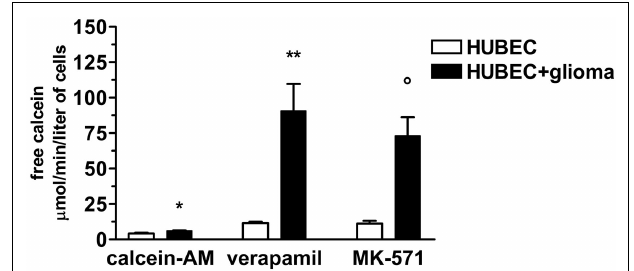
FIGURE 5 | Calcein uptake by brain endothelial cultures in the presence or absence of P-gp and MRP-1 inhibitors (verapamil and MK-571, respectively). The results are expressed as mean ± SEM of duplicate batches of three independent cultures in the presence or absence of glioma cells from three different tumors listed in Table 1 ( n = 3). Calcein-AM, brain endothelial cultures exposed to calcein-AM;Verapamil, brain endothelial cultures preincubated with verapamil; MK-571, brain endothelial cultures preincubated with MK-571; HUBEC, human brain endothelial cells; HUBEC + glioma, human brain endothelial cells in the presence of glioma cells. ∗ HUBEC vs HUBEC + glioma, p = 0.025; ∗∗ HUBEC vs HUBEC + glioma, p = 0.01; °HUBEC vs HUBEC + glioma, p = 0.0075 (paired t